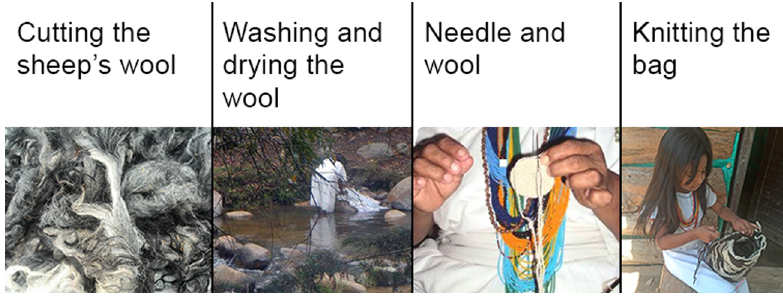
Figure 1. Process of mochila knit. Photos by Dwrya Izquierdo